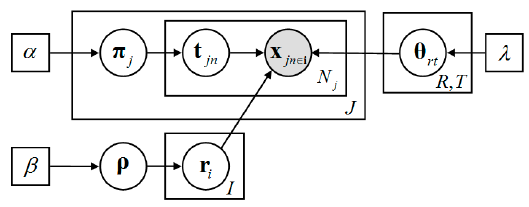
Figure 2. Graphical model of RTM.